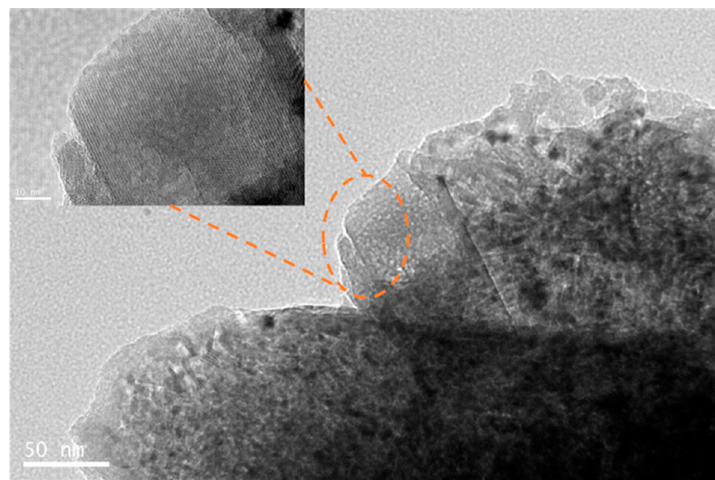
Figure 5. TEM images of HMS calcined at 550 °C.